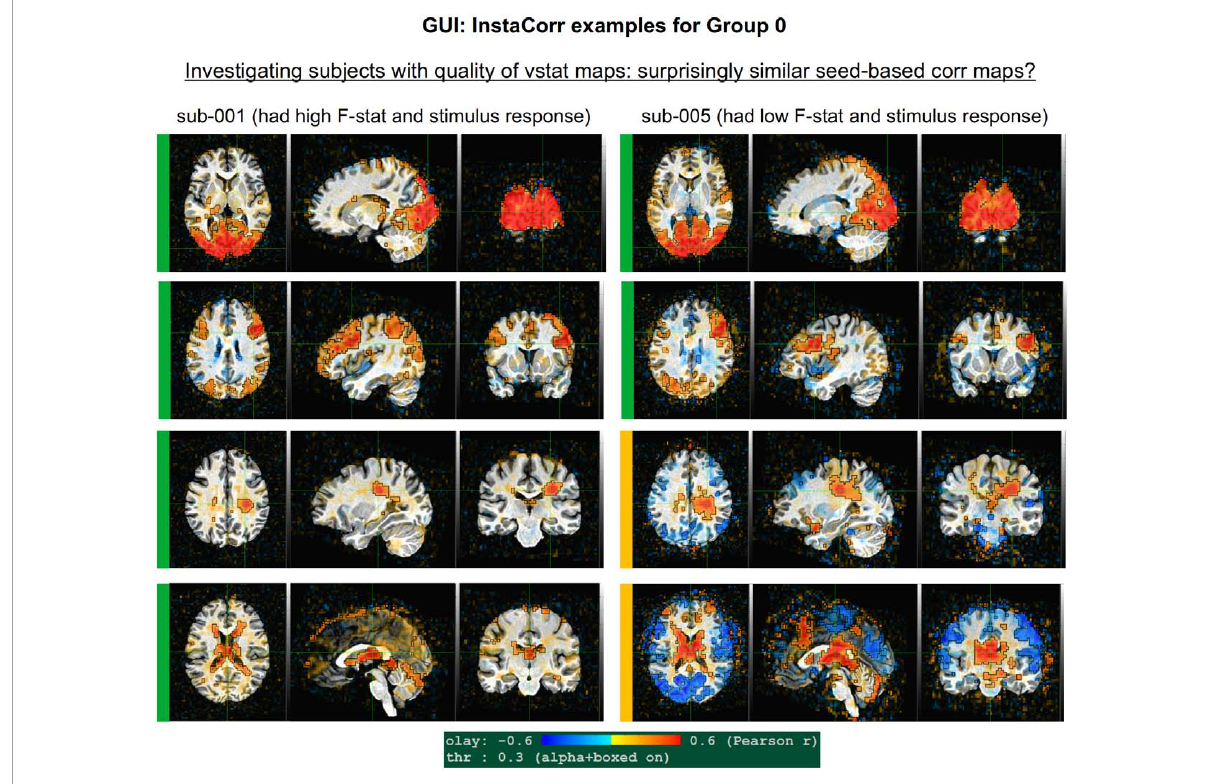
FIGURE15 GUI examples of QC for task-based FMRI, using AFNI’s InstaCorr, to explore the spatiotemporal patterns of the EPI residuals with interactive seed-based correlation. The crosshairs show the seed location for two different subjects: sub-001 (left col) and sub-005 (right col); the same seed location is used, per row of images. The positive correlation responses are quite similar in both supra-threshold spatial coverage and magnitude for seeds in the visual cortex and IFJ (top and second rows, respectively). However, large, unexpected anticorrelation patterns in GM were observed for sub-005, leading to this subject being evaluated as